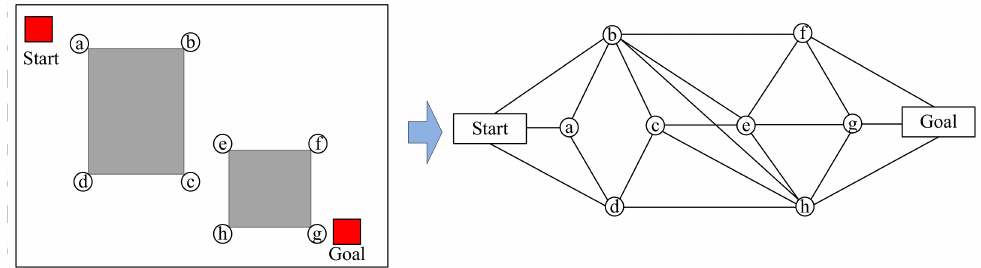
Figure 7. Narrowing the searching space to